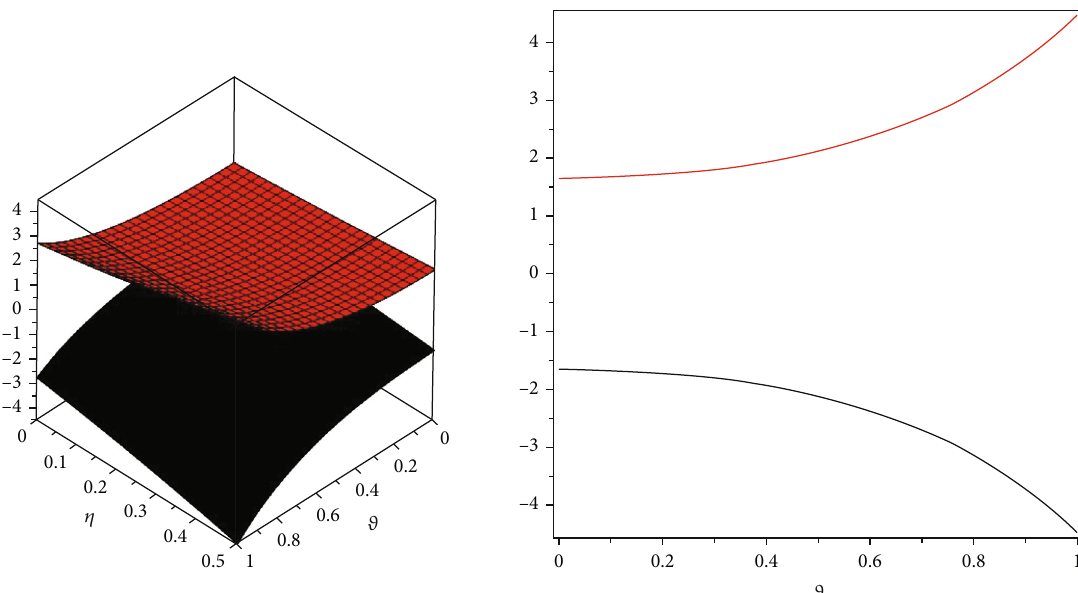
Figure 3: The fi rst fi gure shows the 3D fuzzy upper and lower branches of analytical solution at ϱ = 1 and the 2nd fi gure shows the 2D fuzzy fi gure at ϱ = 1